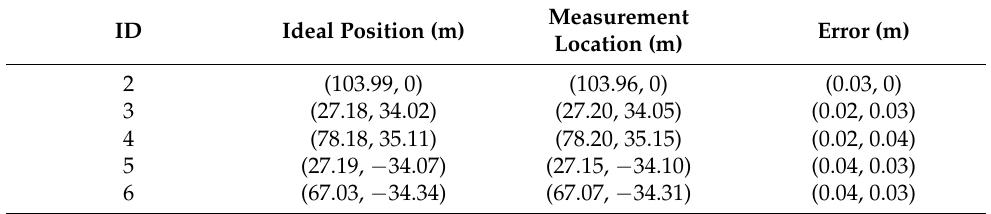
Table 2. Comparison of base station positioning coordinates and total stations positioning coordi- nates.